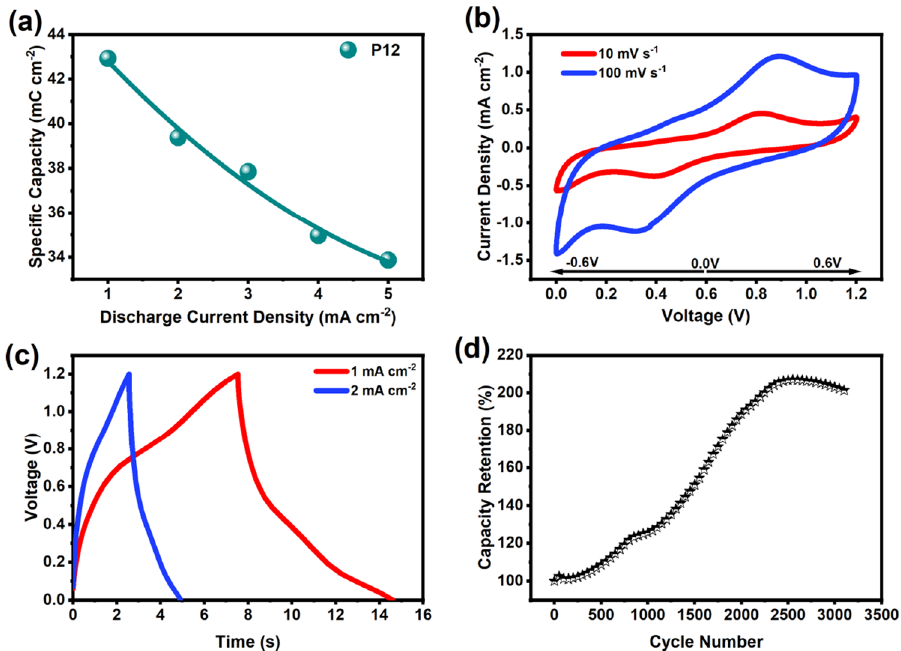
Figure 9. ( a ) The areal capacitance of P12 is calculated with CV at different scan speeds. ( b ) The CV almost demonstrates excellent reversibility at both 10 and 100 mV s −1 scan rate ( c ) The charge–discharge curve